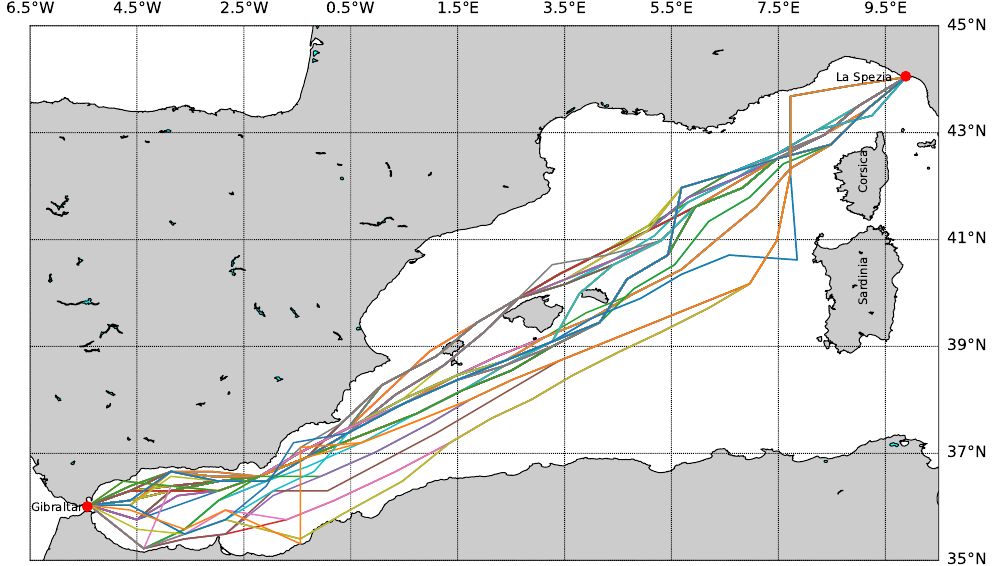
Figure 7. Set of Pareto efficient routes generated through the weather-routing process in the selected